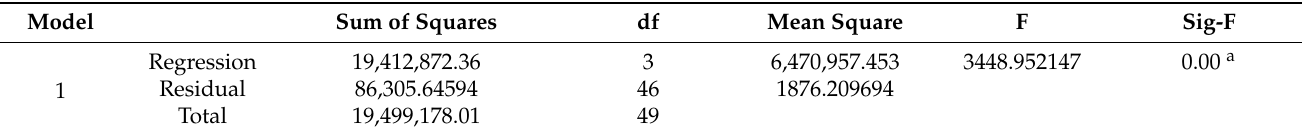
Table 1. Analysis of variance